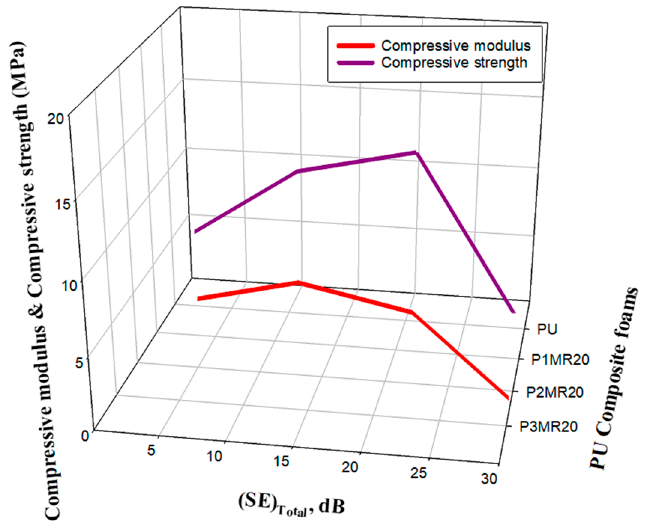
Figure 14. The optimization among the filler loading, SE, and mechanical properties.